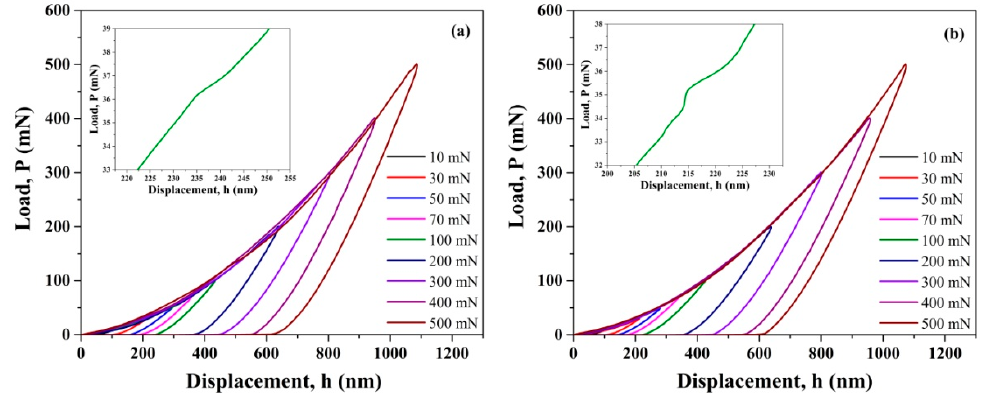
Figure 2. Typical P-h curves with different peak loads: ( a ) ZTA10; ( b ) ZTA30. The left inset of each figure presents the magnified serration.